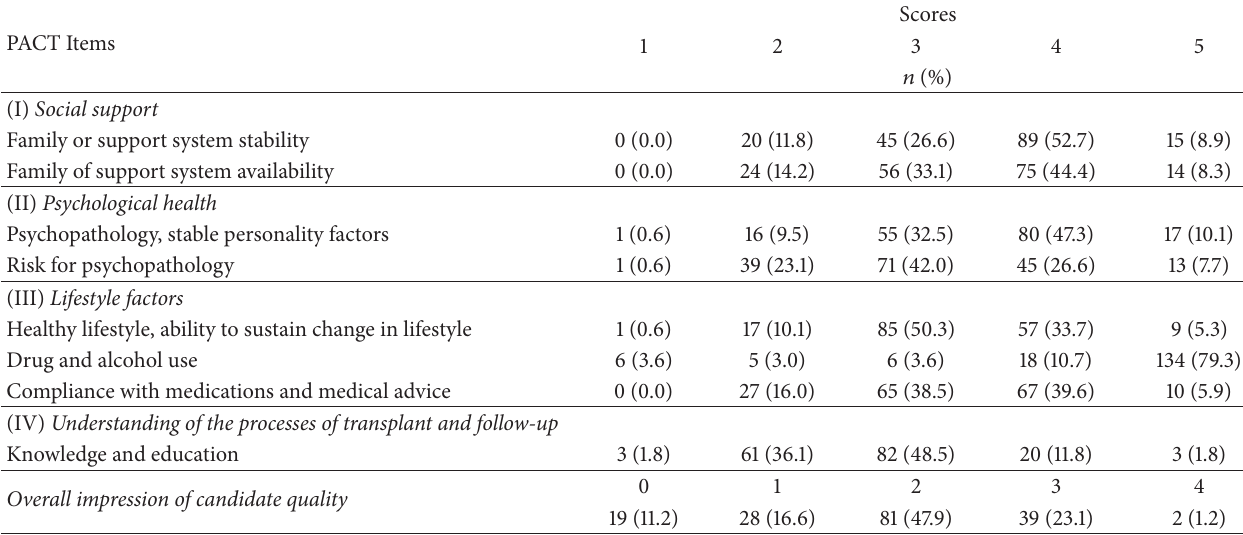
Table 3: Psychosocial Assessment of Candidates for Transplantation (PACT) Scores among Iranian liver transplant candidates ( 𝑛 = 205 ). PACT Items